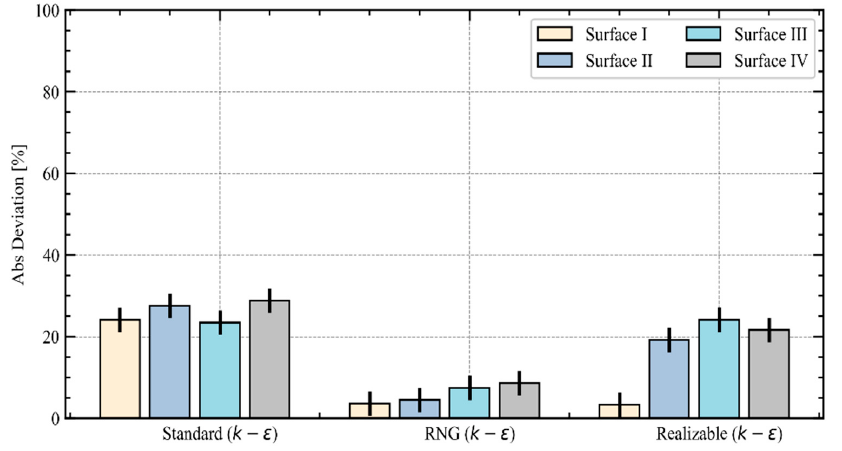
Figure 4. Comparison of numerical Cp values in each building surface (face) to the experimental reference.